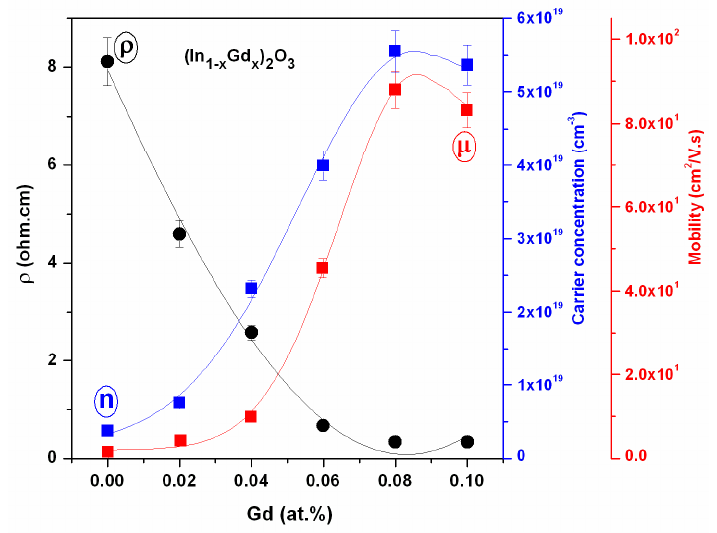
Figure 12. Electrical parameters in terms of Hall measurements as a function of Gd content for (In 1 − x Gd x ) 2 O 3 thin (In 1 − x Gd x ) 2 O 3 thin films.